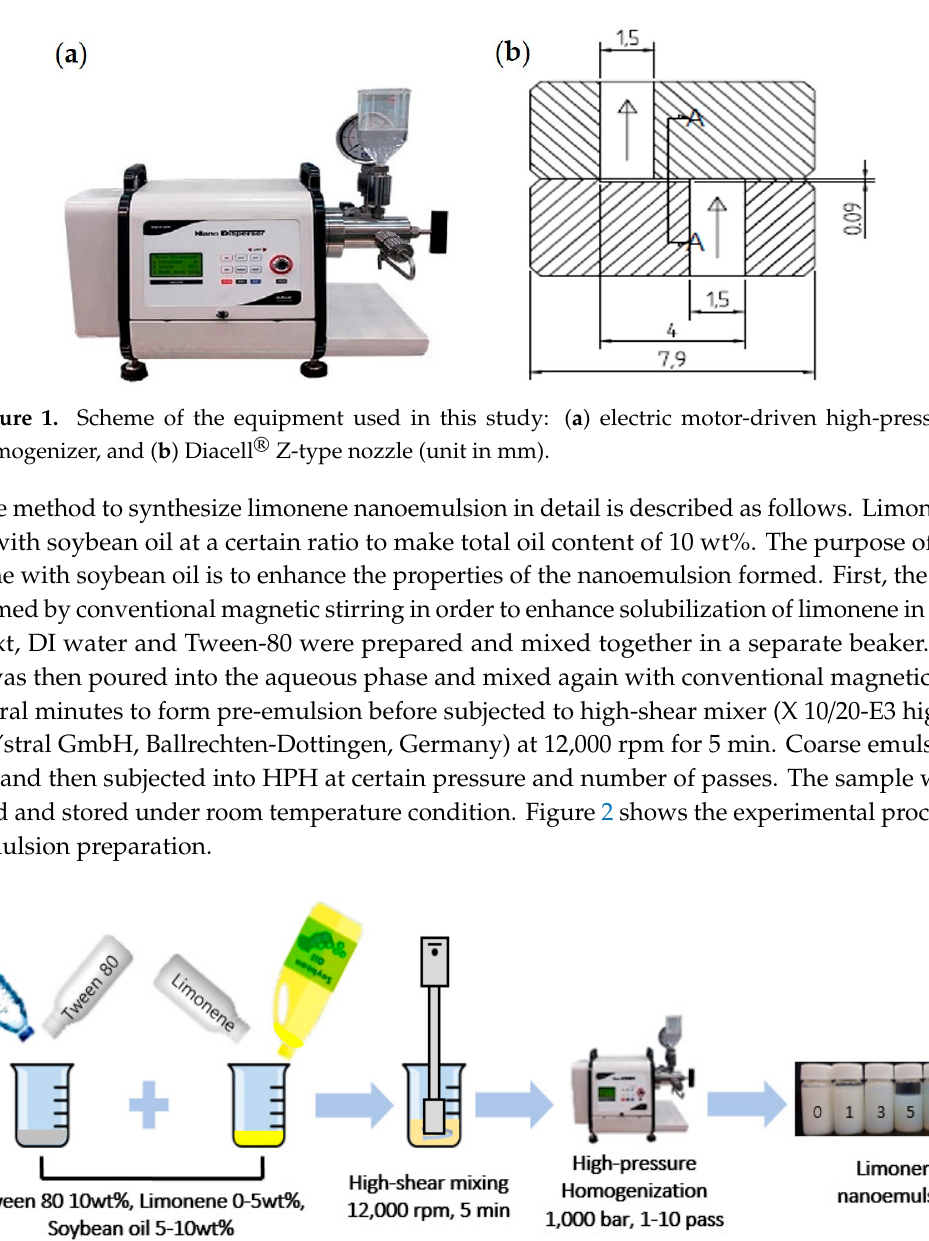
Figure 2. Experimental scheme.